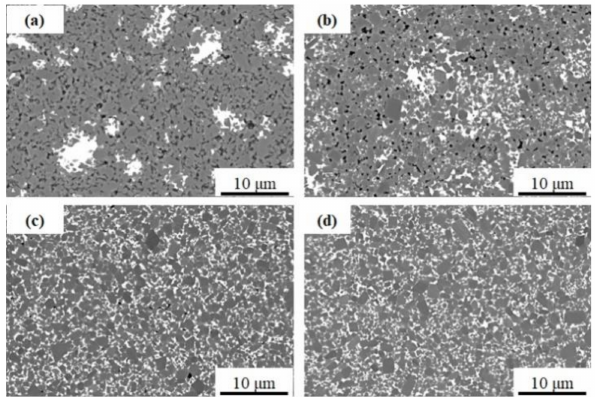
Figure 4. Polished surfaces of sintered SiC samples with 9 wt.% Y 2 O 3 -Er 2 O 3 at di ff erent sintering temperatures: ( a ) 1850 ◦ C, ( b ) 1900 ◦ C, ( c ) 1950 ◦ C, and ( d ) 2000 ◦ C.